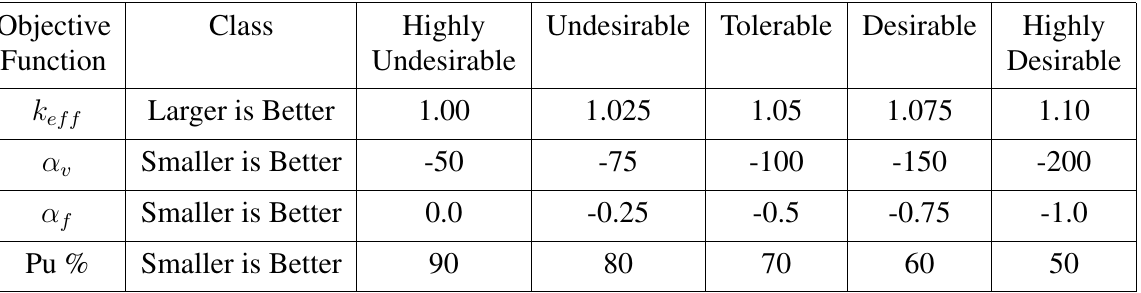
Table 2: Ranking Scheme for Physical